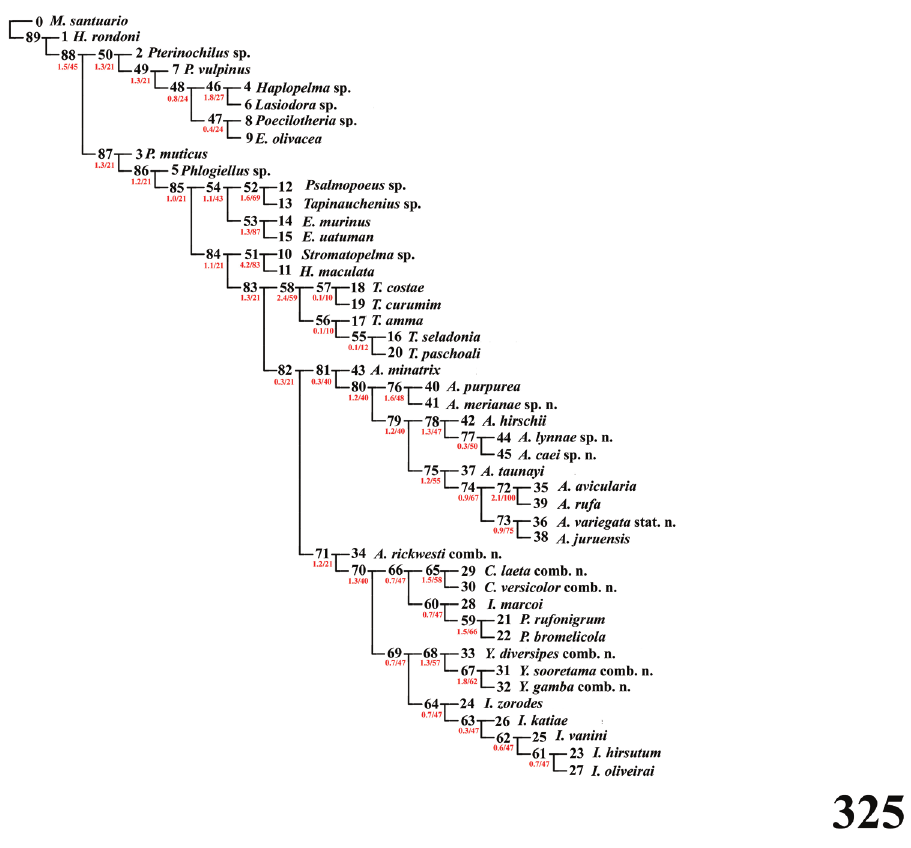
Figure 325. Single tree obtained with Piwe, all characters as non-additive and concavity 6. Fit = 5051.44 and length = 230. Bremer support values (absolute and relative) of each node are in